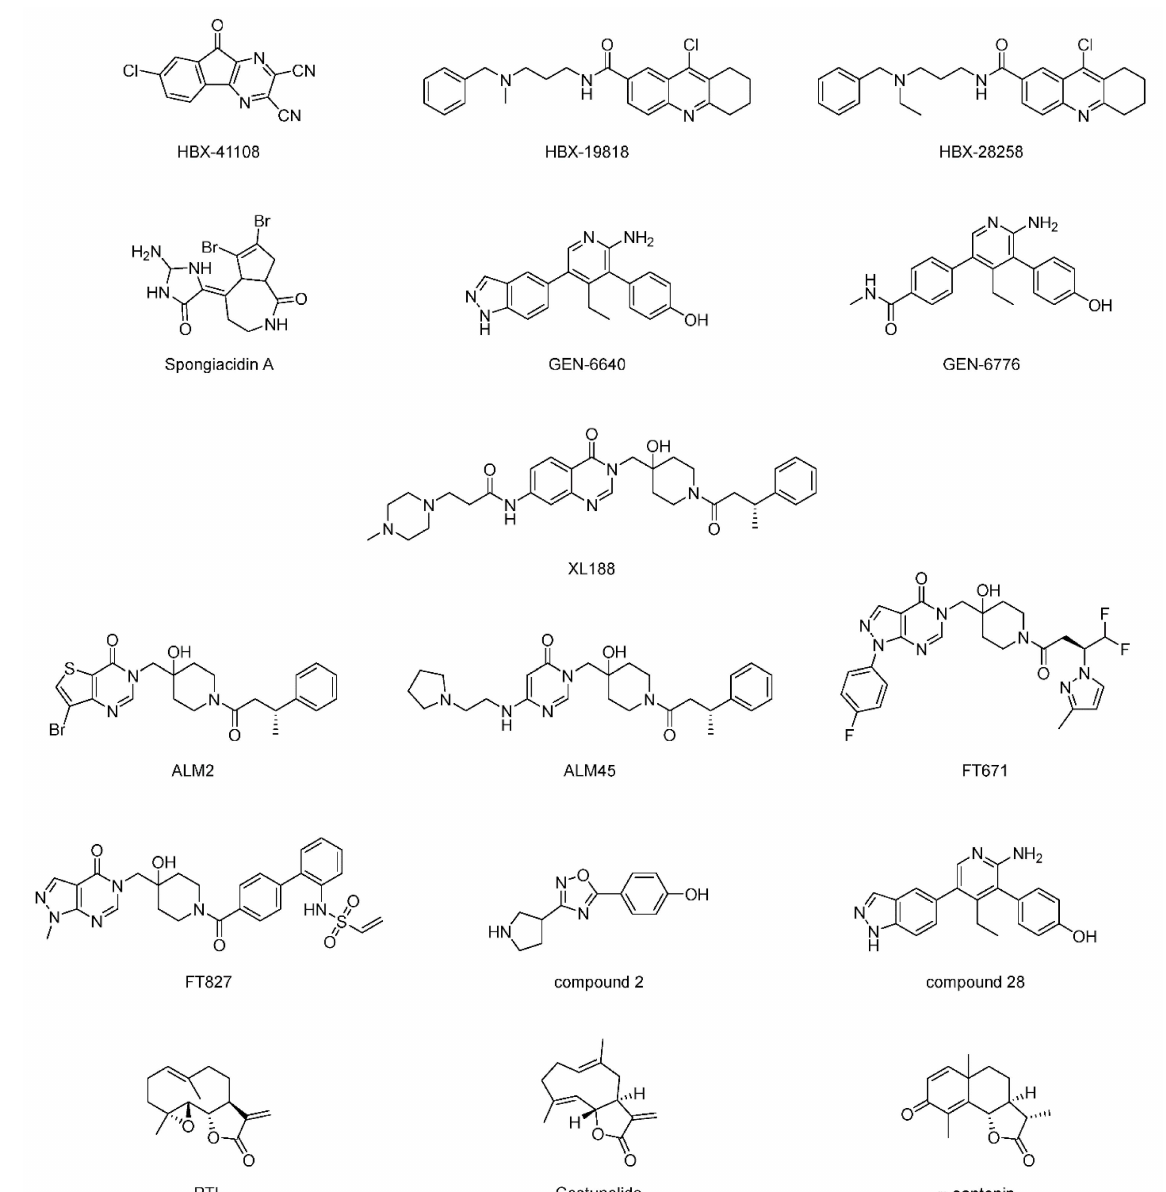
Figure 14. Structures of representative USP7